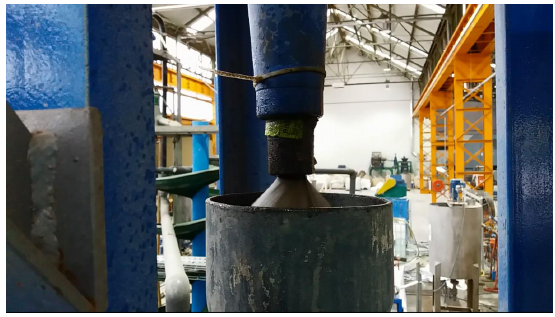
Figure 16. Hydrocycloning step.